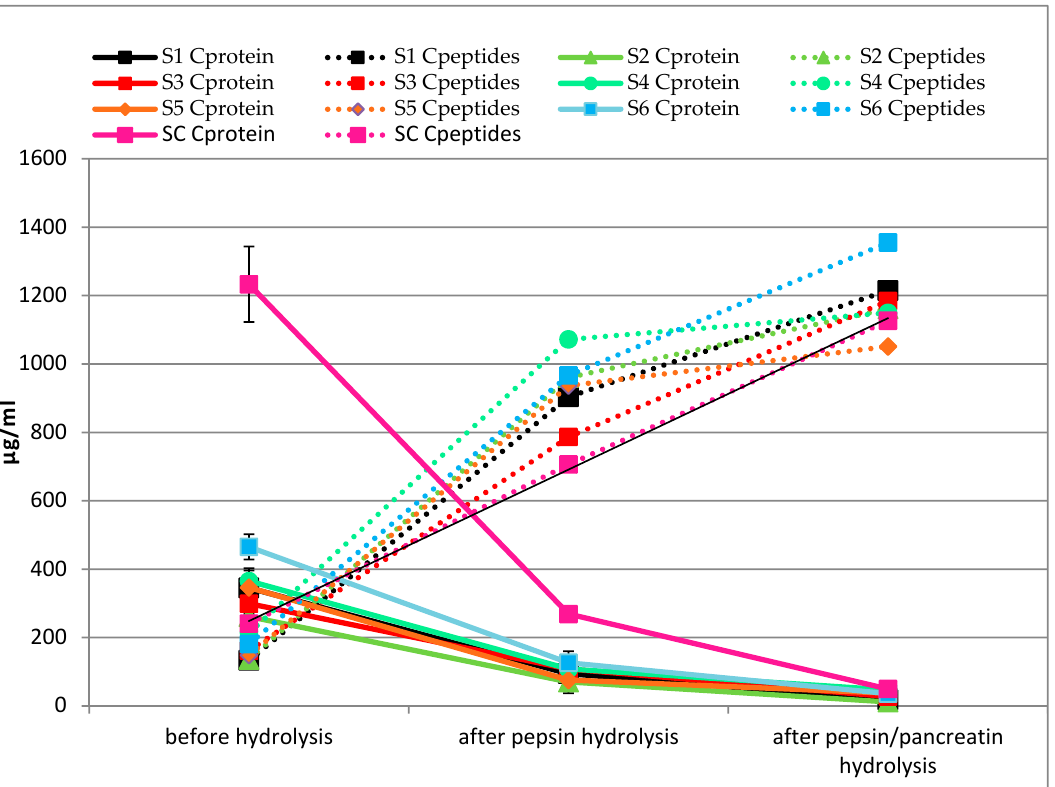
Figure 1. Protein and peptide content (µg mL − 1 ) during in vitro hydrolysis of cooked beef steaks.